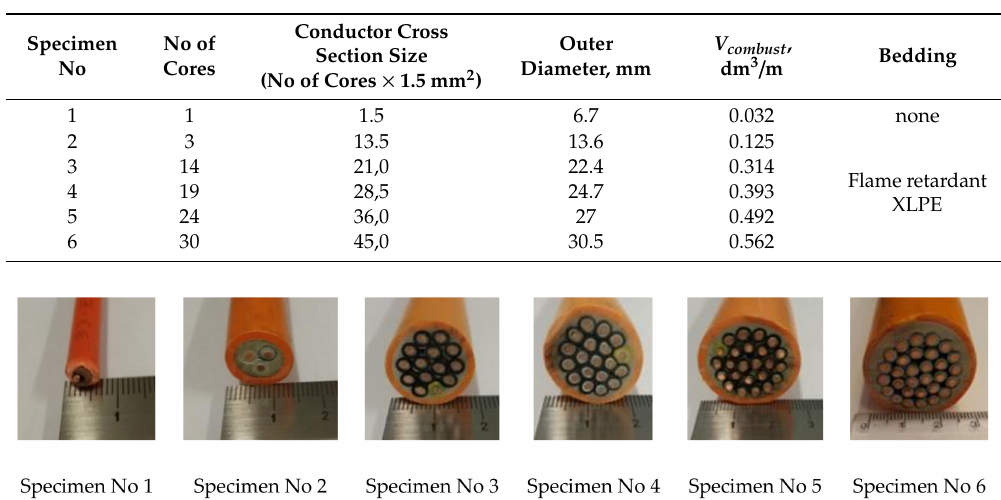
Figure 1. View of the cross-sections of the